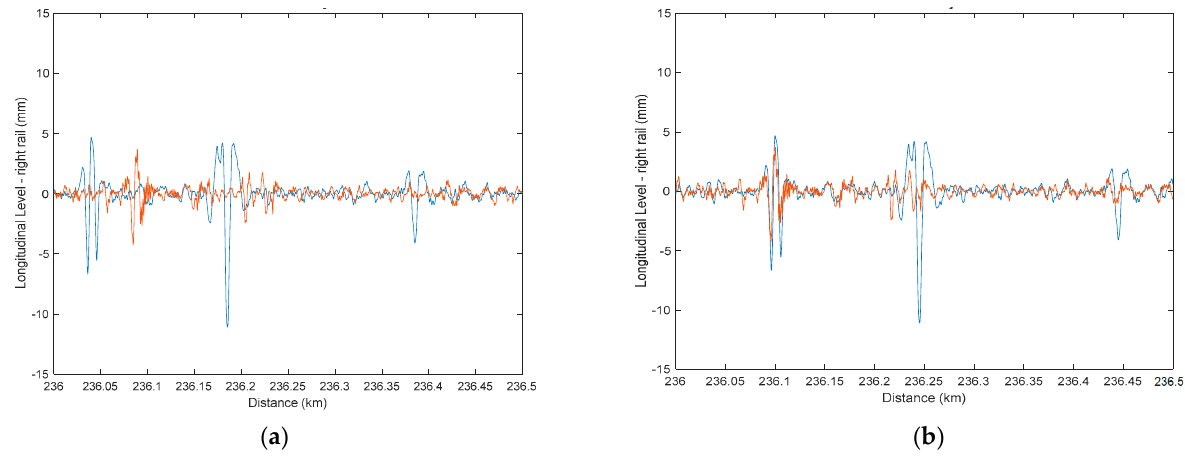
Figure 8. Synchronization of Longitudinal Level—right rail: ( a ) before and ( b )